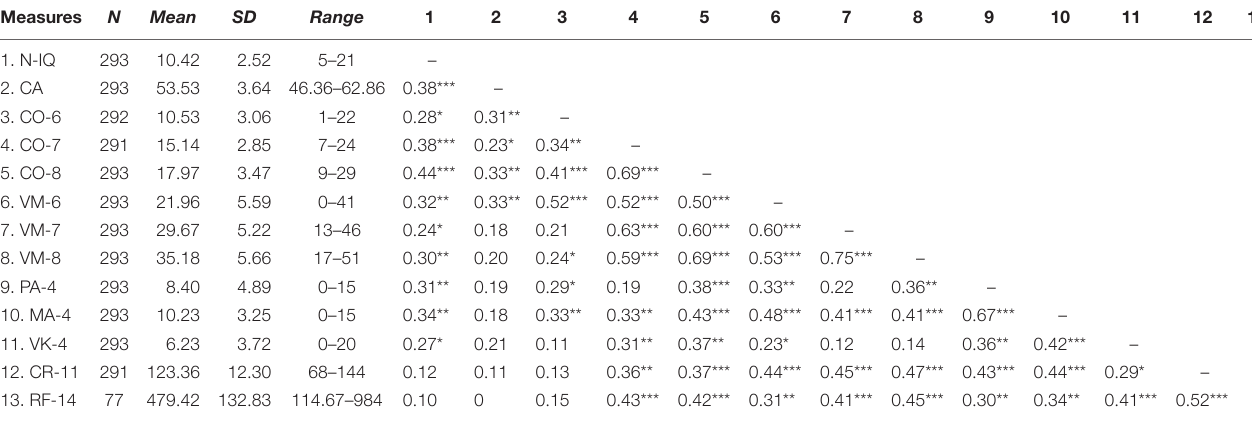
TABLE 1 | Descriptive statistics and correlations among behavioral measures. Measures